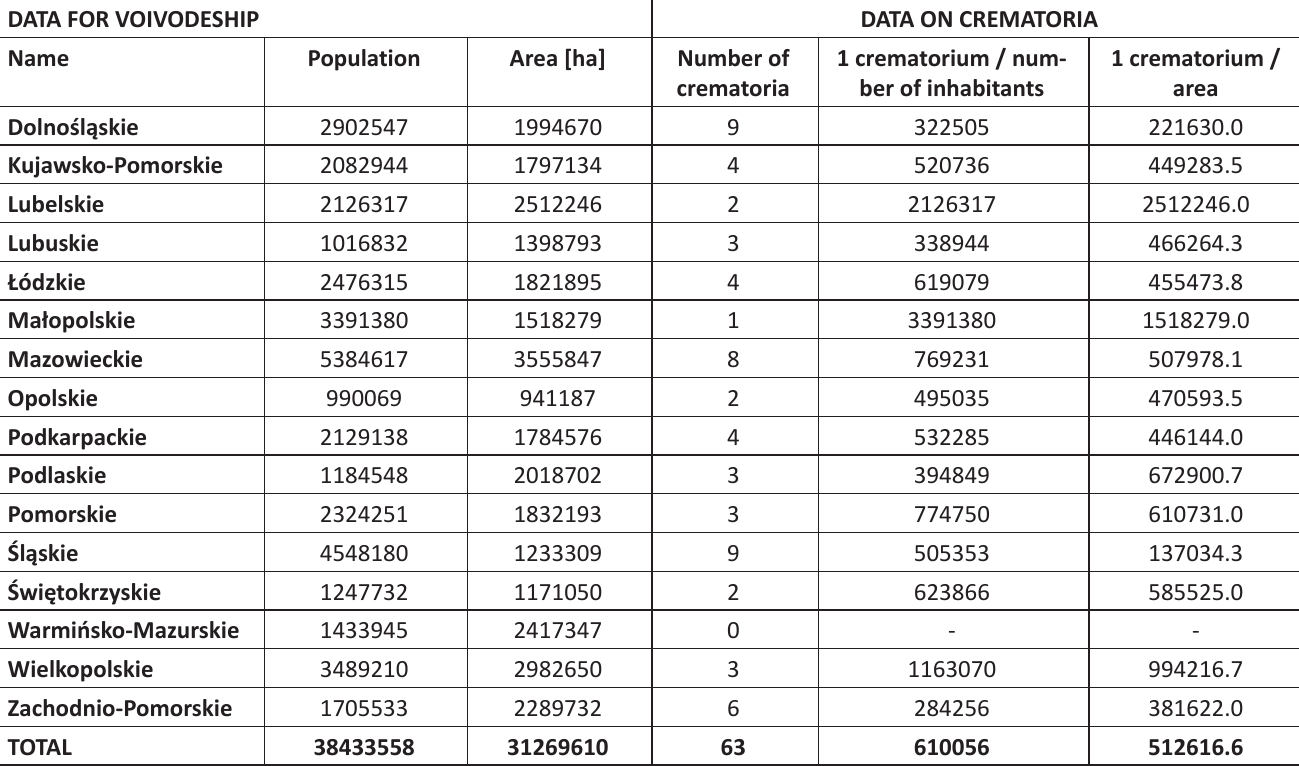
Table 1. Crematoria by voivodeships in Poland. Own